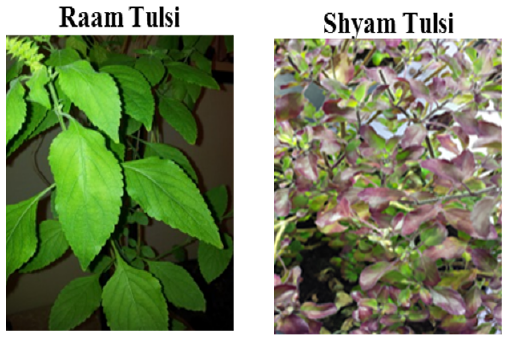
Figure 2. Raam and Shyam (Krishna) Tulsi grown in the UK ( pictures by S.K.Bhamra ).